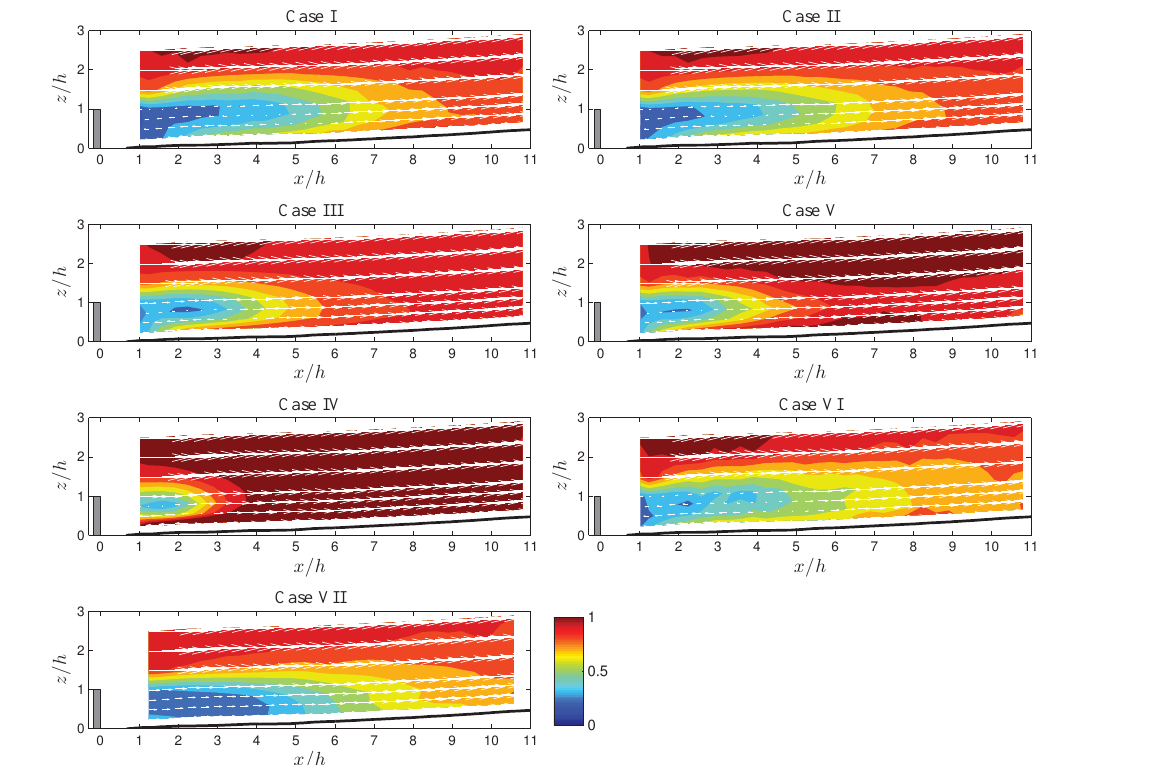
Figure 8. Averaged wind-speed ratio (cid:104) e U ( x , z ) WS (cid:105) / (cid:104) U o ( z ) (cid:105) (colourbar) behind the fence for a number of cases. Vectors indicate the magni- (cid:2) U ( z ) Figure 8. Averaged speed-up WS (cid:3) / (cid:2) U o ( z ) (cid:3) behind the fence for a number of cases. Vectors indicate the magnitude and direction (cid:2) tude and sign of the ensemble-averaged u of the ensemble-averaged u -component